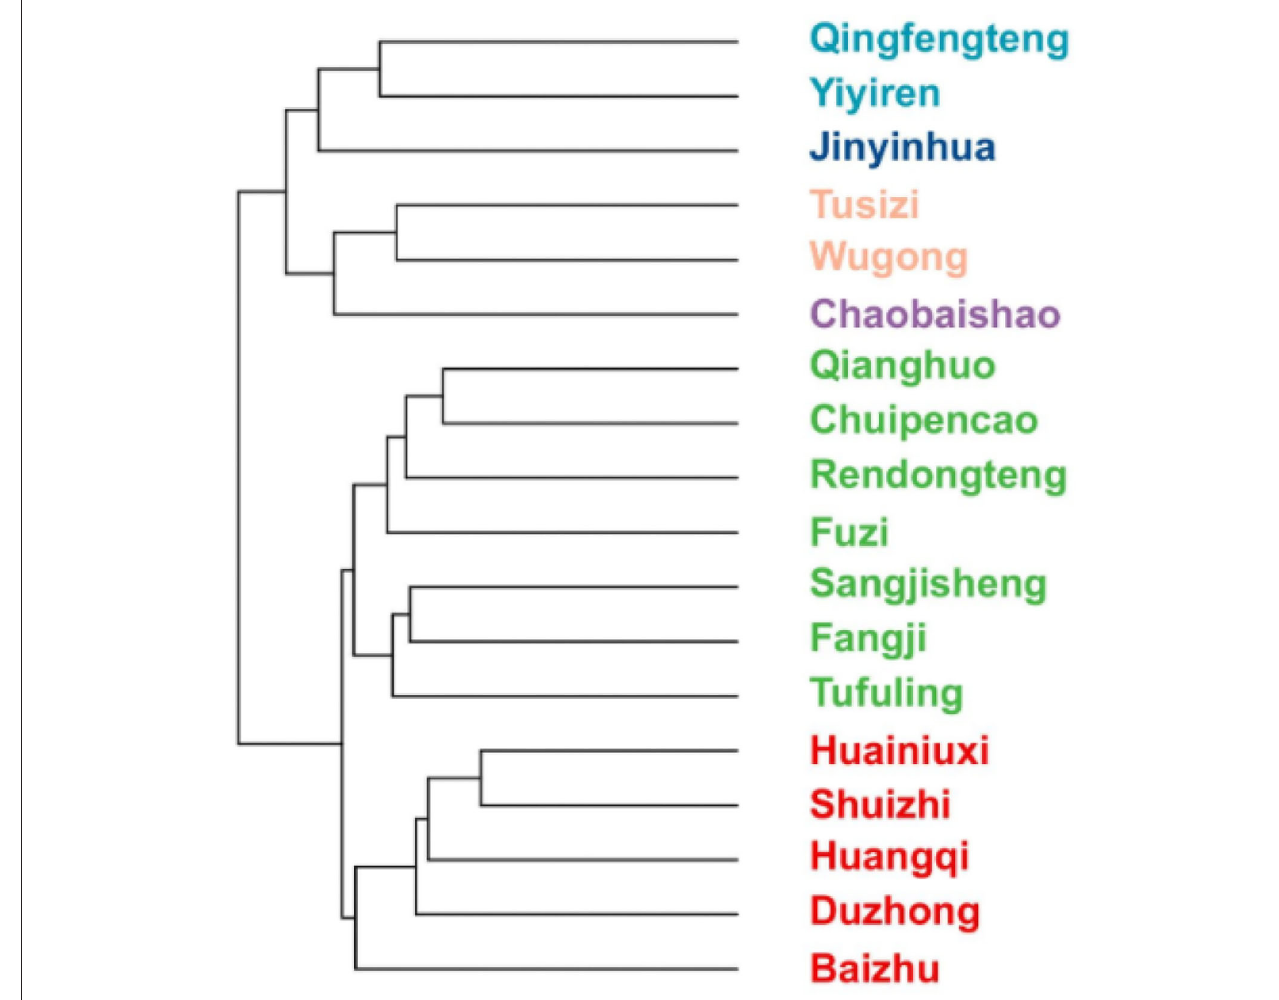
FIGURE 9 | Tree diagram of systematic clustering of high frequency used